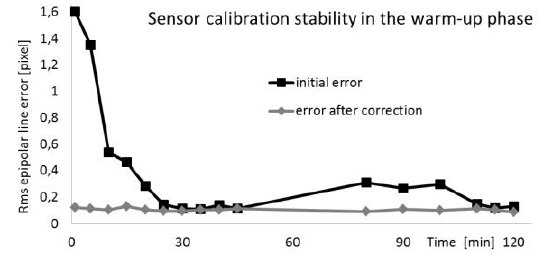
Figure 7: Rms epipolar line error of scanner DS 2 over two hours from switch on, 2011/05/13, measuring object: teeth arc